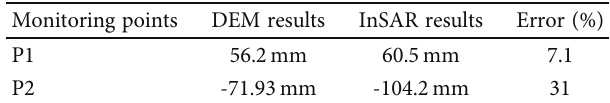
Table 4: Vertical displacement comparison between InSAR results and DEM